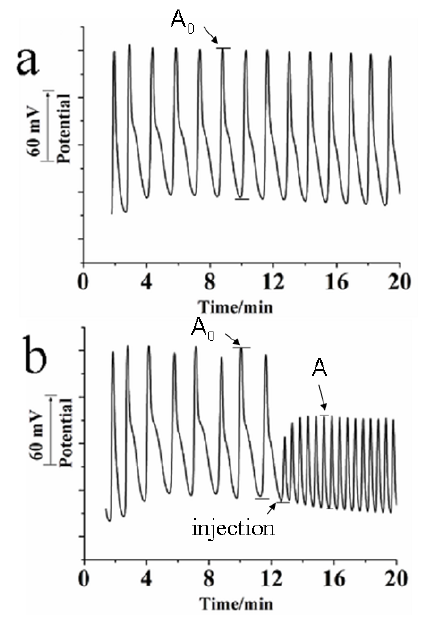
Figure 1. Typical oscillation profiles for the proposed oscillation system in the absence (a) and presence (b) of 2×10 -5 M pyridoxine hydrochloride perturbation using a platinum electrode. Common conditions: [NaBrO [H SO ] =1.0 M, [malic acid] =0.18 M, [CuL] (ClO 2 4 =3.595×10 -3 M. T=18.3 º C. (a) [pyridoxine hydrochloride] = 0.000 M; (b) [pyridoxine hydrochloride] = 2×10 -5